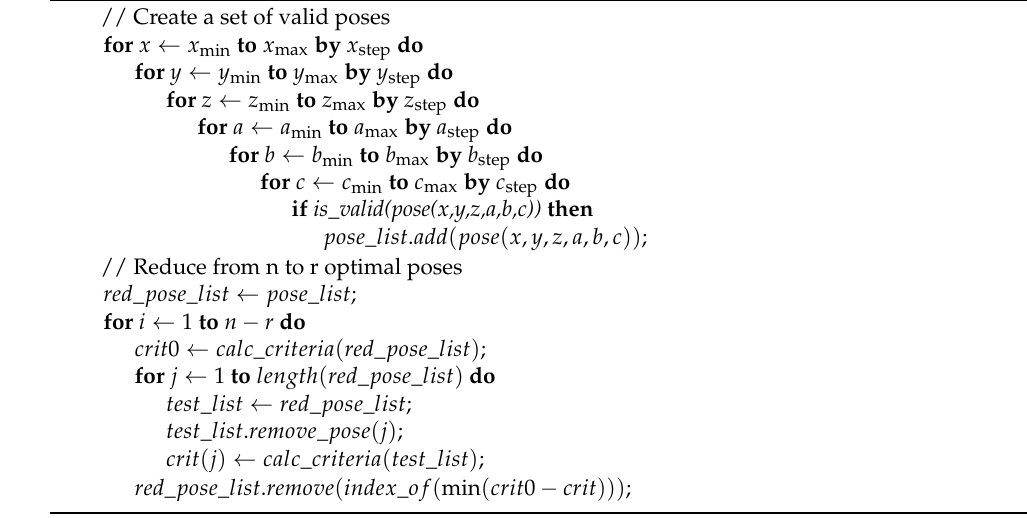
Algorithm 1: Selection of optimal poses using criteria of Table 5.